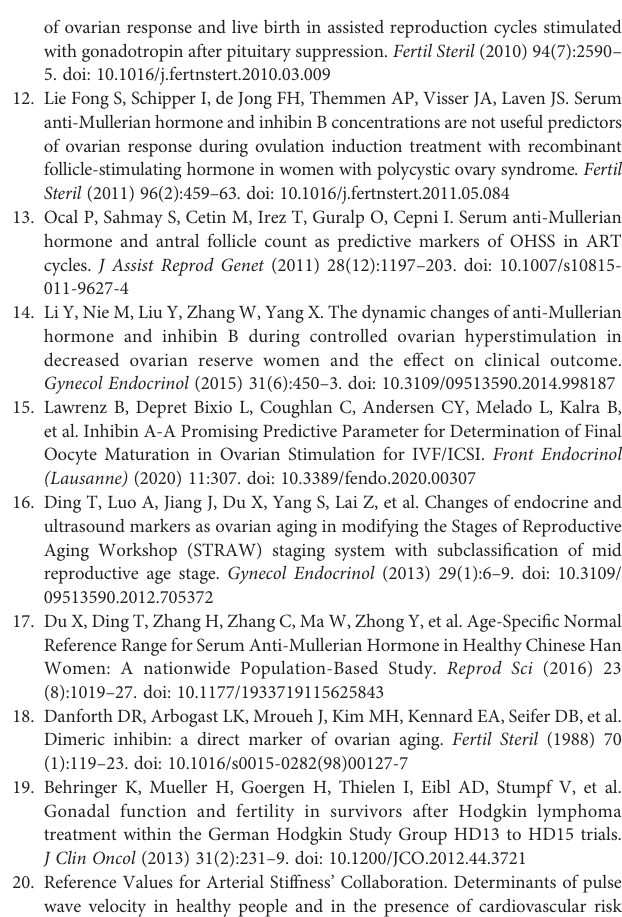
Supplementary Figure 1 | The levels of hormones and BMI changed with